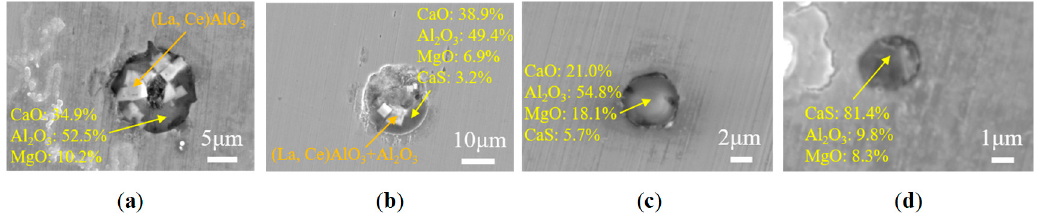
Figure 6. Typical morphologies and compositions of inclusions in the tundish impact zone. ( a ) (La,Ce)AlO 3 +Al 2 O 3 -MgO-CaO; ( b ) (La,Ce)AlO 3 -Al 2 O 3 +Al 2 O 3 -CaO-MgO-CaS; ( c ) Al 2 O 3 -MgO-CaS-CaO; ( d ) Al 2 O 3 -MgO-CaS.